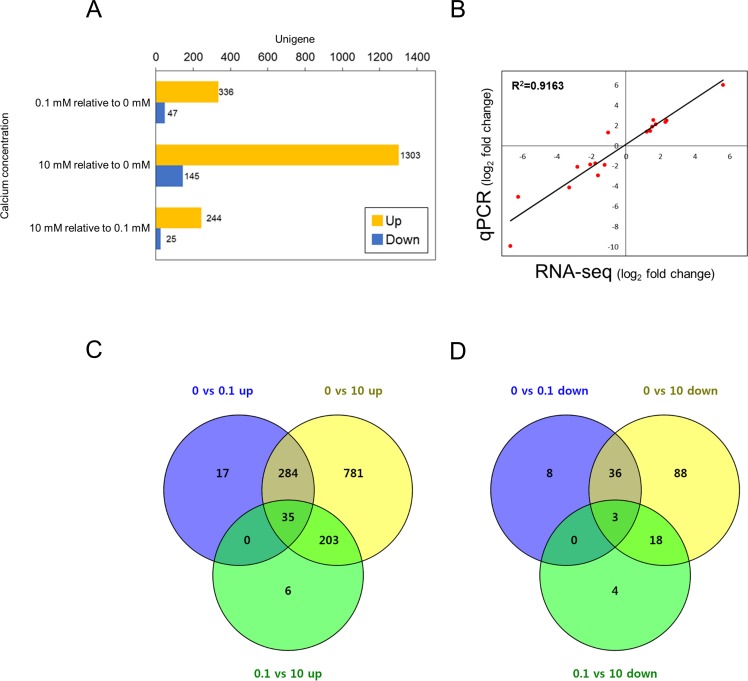
Differentially expressed genes (DEGs) involved in E. huxleyi at different calcium concentrations.(A) DEGs from each comparison of different calcium concentrations. Bar charts show up-regulated and down-regulated DEGs in yellow and blue, respectively. (B) Correlation between RNA-seq data and qPCR analysis for validation. (C, D) DEG comparison of the (C) up- and (D) down-regulated groups. The Venn diagram was drawn by Venny2.1 [36].